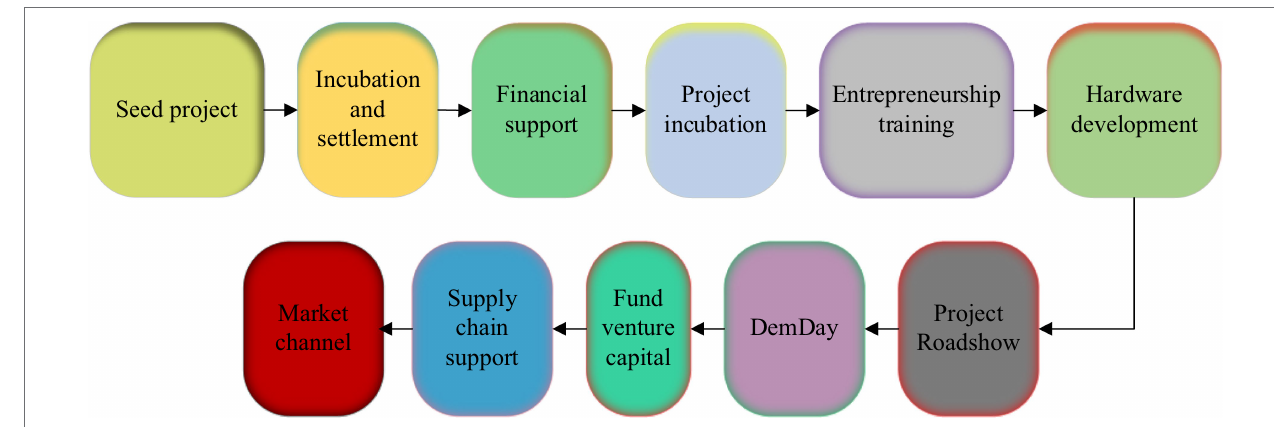
FIGURE 1 | Innovation and entrepreneurship process of food